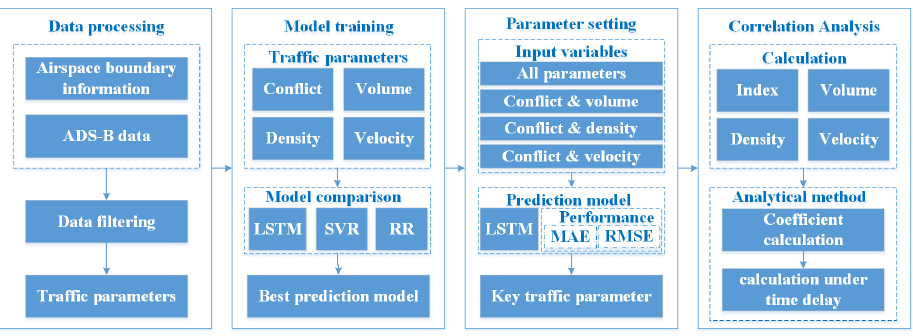
Figure 1. Research